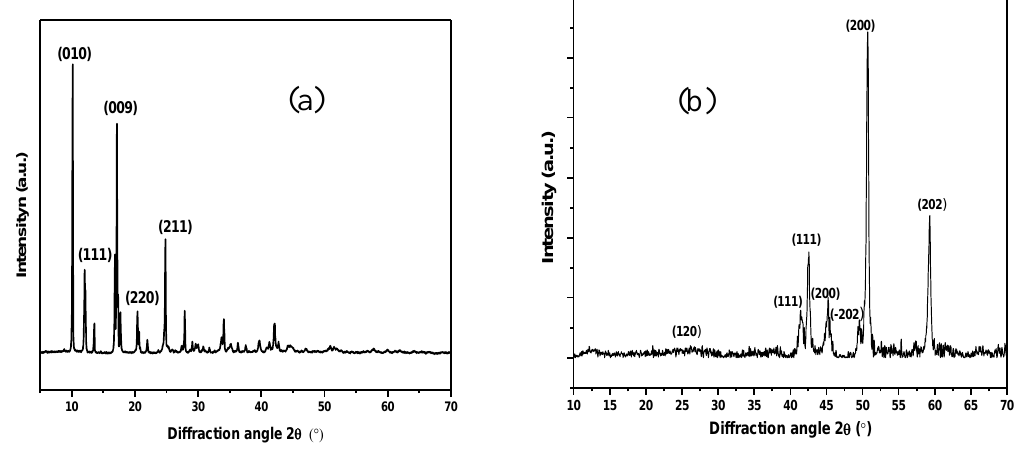
Figure 5. XRD patterns of ( a ) Cu-tpa MOF, ( b ) CuPt / NC with (hkl) values .